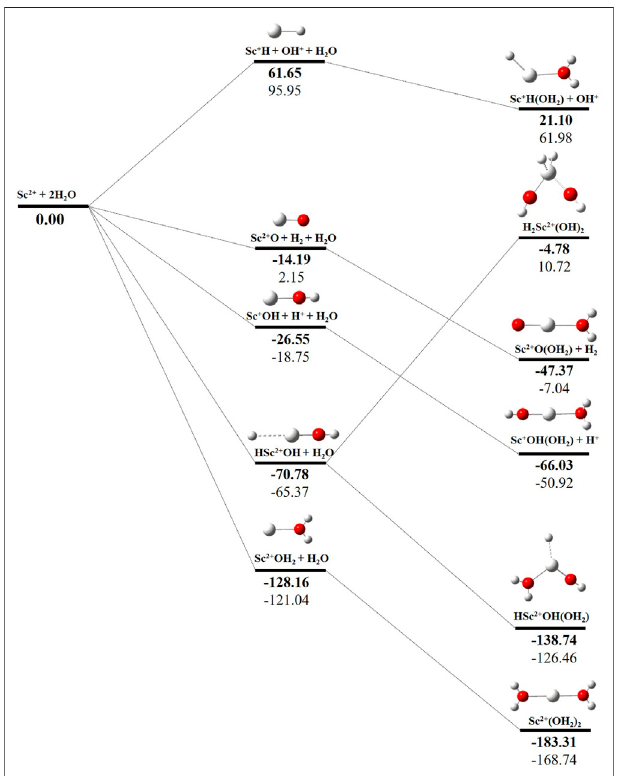
FIGURE 7 | CCSD(T)/6-311G**//MP2/6-31G* (bold) and MP2/6- 311G**//MP2/6-31G* (normal) energies (kcal/mol) for singlet-state (SS) potentialenergysurfacesfollowingSc 3+ +2H 2 Oreaction.Thesumofreactant pair energy (Sc 3+ + 2H 2 O) is considered as a standard (energy zero) to calculate the relative